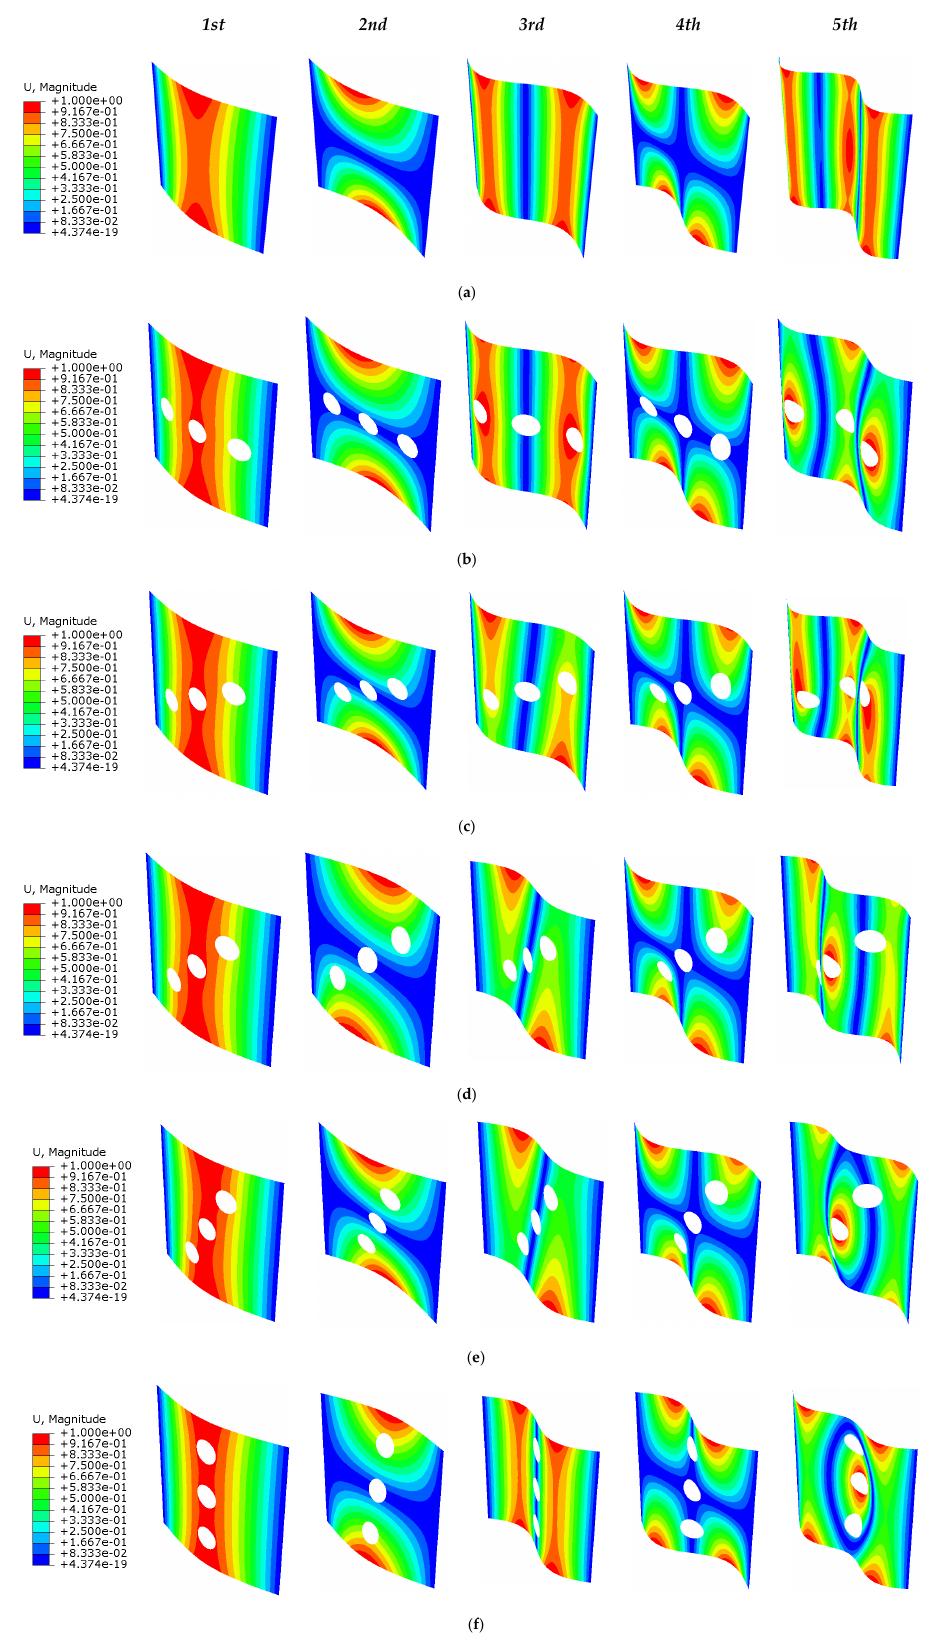
Figure 8. The first five buckling modes of FGM plates with ( a ) a plate thickness of 25 mm, a cutout diameter of 200 mm, and an arrangement of ( b ) 0 ° , ( c ) 30 ° , ( d ) 45 ° , ( e ) 60 °, and ( f ) 90 ° .